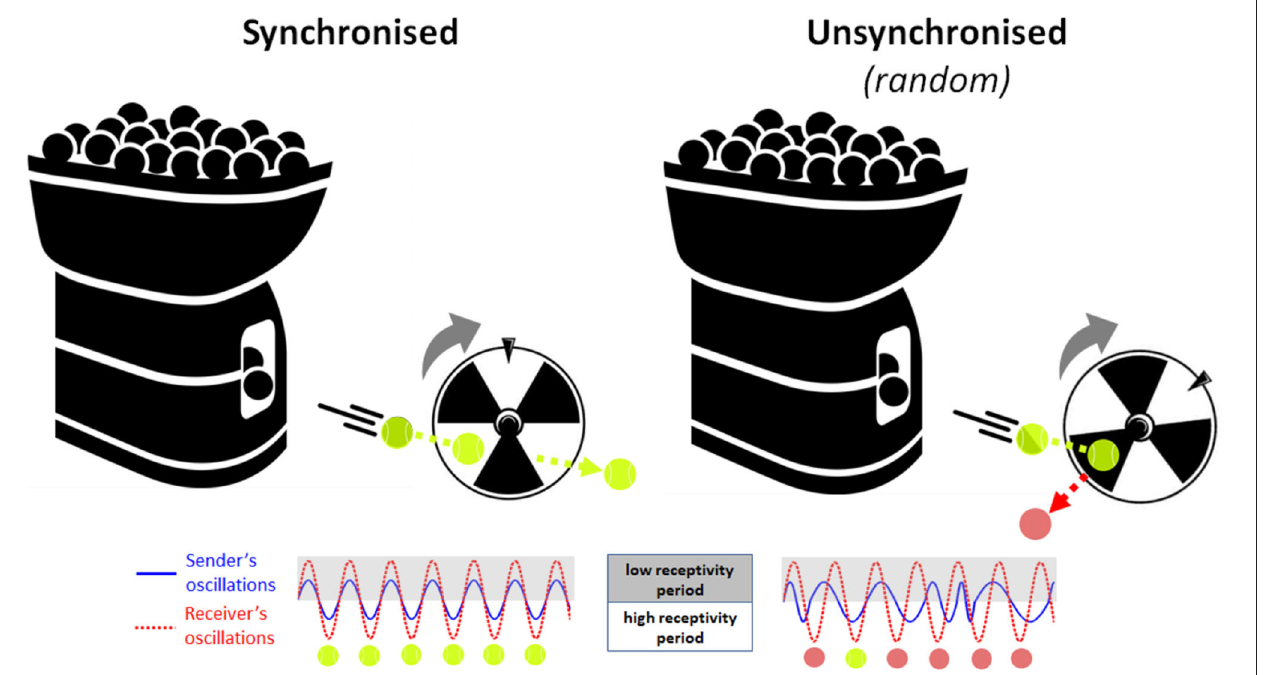
FIGURE 1 | Analogical illustration of the Learning through Interpersonal Neural Coupling (LINC) hypothesis. Here, the tennis ball machine (information sender) attempts to fire balls through the blades of a rotating wheel (information receiver). (Left) If the timing of ball firing is well-synchronised to the rotation pattern of the wheel, then every ball passes successfully between the blades every time. (Right) Conversely, if the balls are fired randomly without reference to the phase of the turning wheel, then many balls will hit the blades and bounce out and only a few will pass through by chance. Therefore, synchronisation permits all the information (balls) to be safely transmitted from the sender (machine) to the receiver (wheel), where the timing of ball firing and wheel rotation represent the neuronal oscillation patterns of the information sender (blue solid line) and the information receiver (red dotted line),